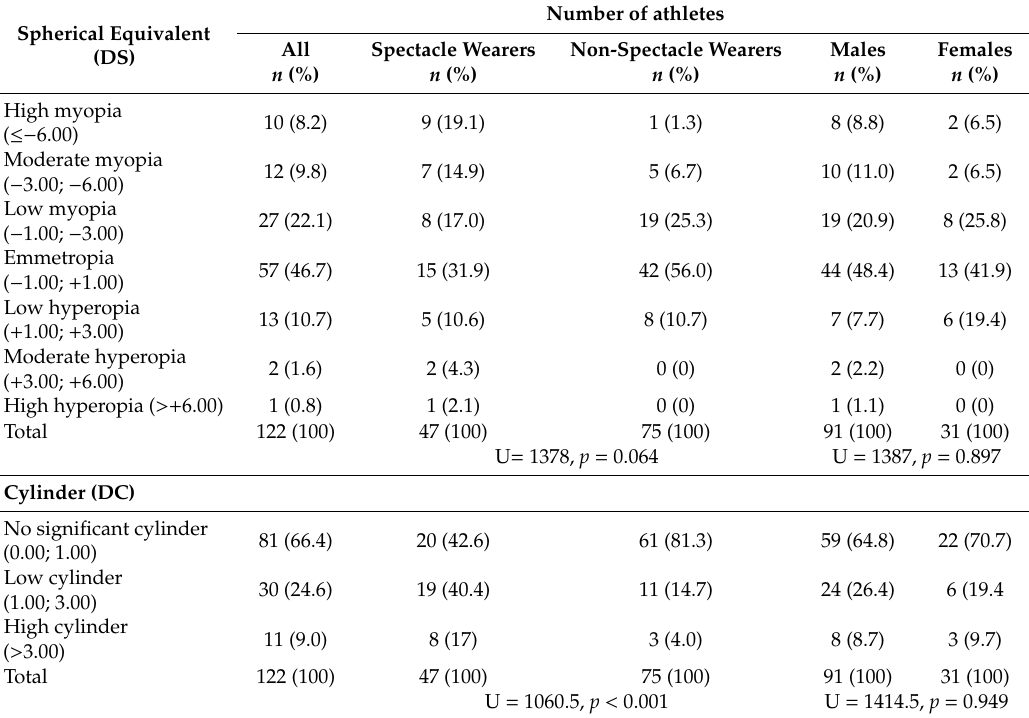
Table 7. Athletes’ classification according to ametropia.